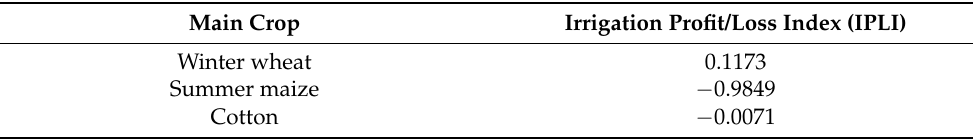
Table 4. Irrigation profit/loss index (IPLI) of the main crops in Quzhou County in